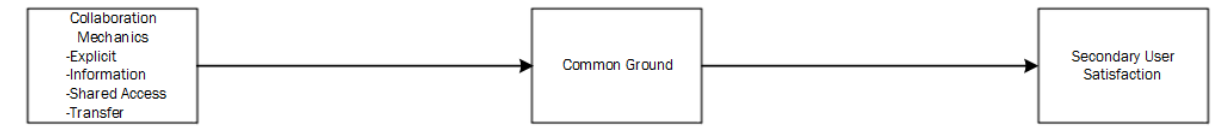
Figure 1. The conceptual model for the research